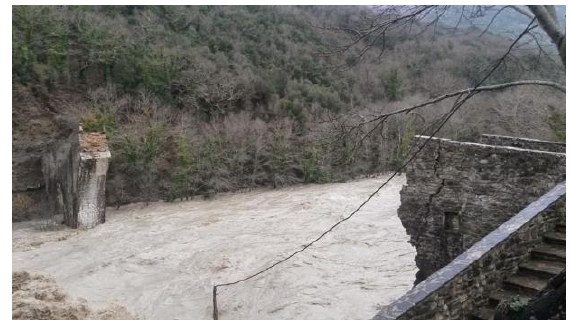
Figure 1: The Plaka Stone Bridge Figure 3: The remains of the bridge after destruction